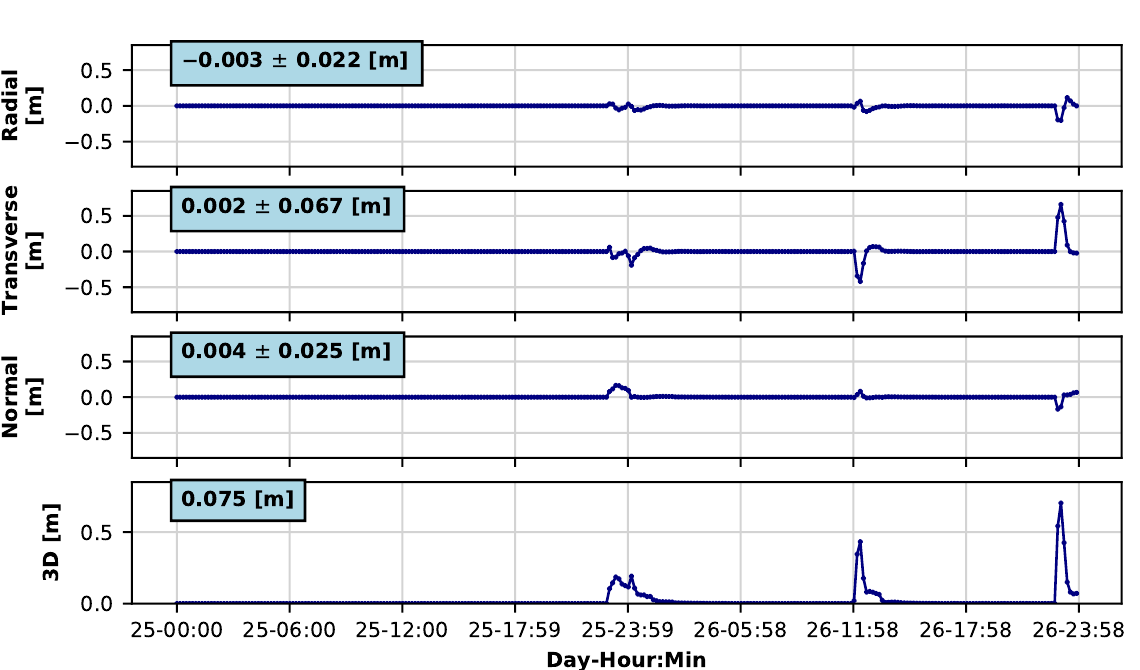
Figure 5. Solution difference between applying and not applying the ambiguity re-initialization. For the individual axes (RTN frame), the mean values provided. The RMS value is shown for the 3D panel.